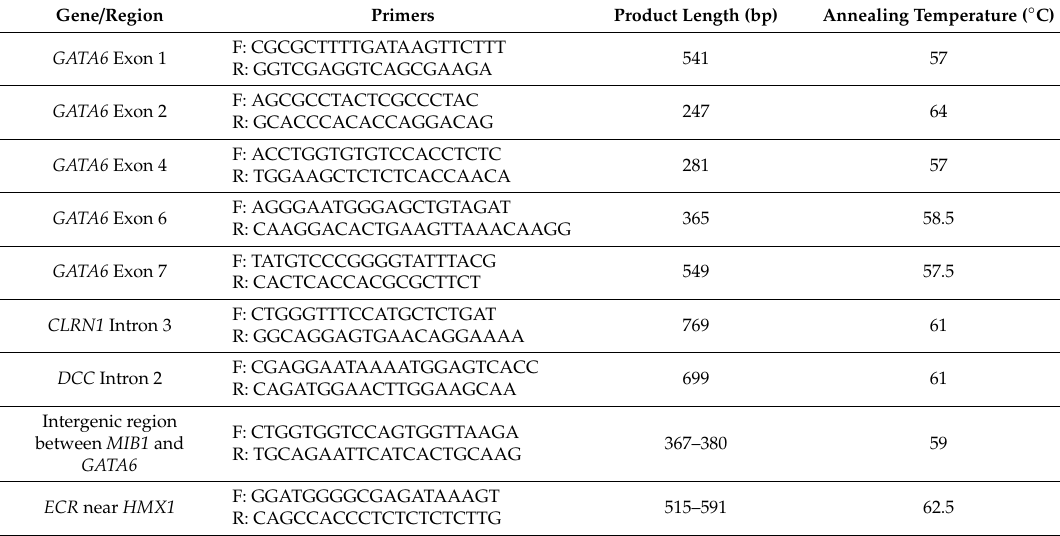
Table 1. Forward and reverse primers, product length and optimal annealing temperature for the genes screened in the